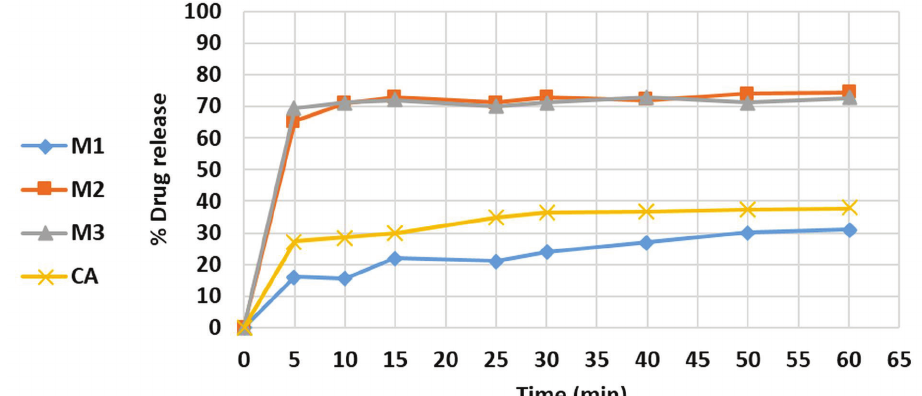
FIGURE 4 - In vitro dissolution profiles of cefuroxime axetil and solid dispersions prepared by melt evaporation